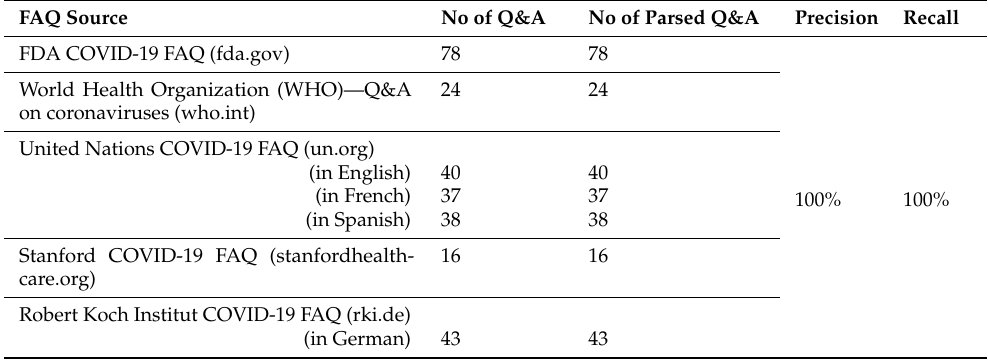
Table 3: Analysis of FAQs to demonstrate the framework’s domain independence and generalized nature. FAQ FAQ Source No of Q&A No of Parsed Q&A Precision Recall 78